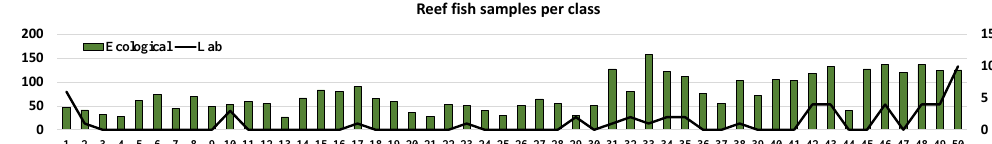
Figure 6. The images per class in the reef fish dataset. Similar to the butterfly images, ecological images are those taken in the natural habitat of the fish while the lab images are taken in a controlled environment such as in the lab. The left y-axis (min = 0, max = 200) represents the count of ecological images where the right y-axis (min = 0, max = 15) represents the count of lab